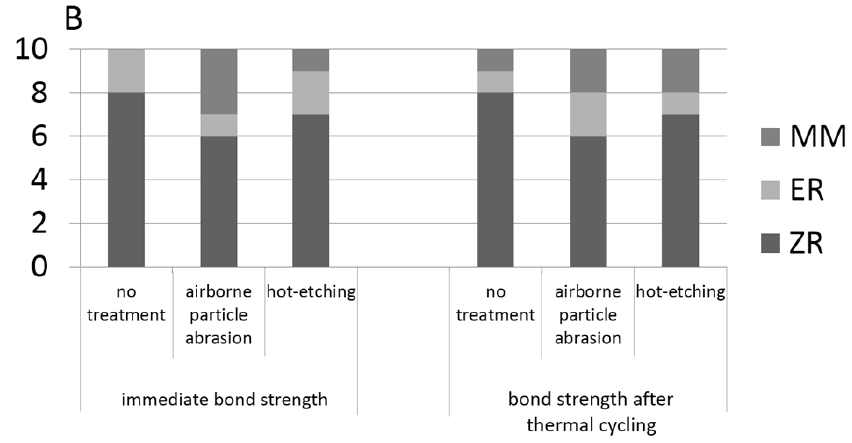
Figure 2. Percentage of different failure modes in each group. ( A ) Bonded with Superbond resin cement; and ( B ) bonded with Panavia F2.0.